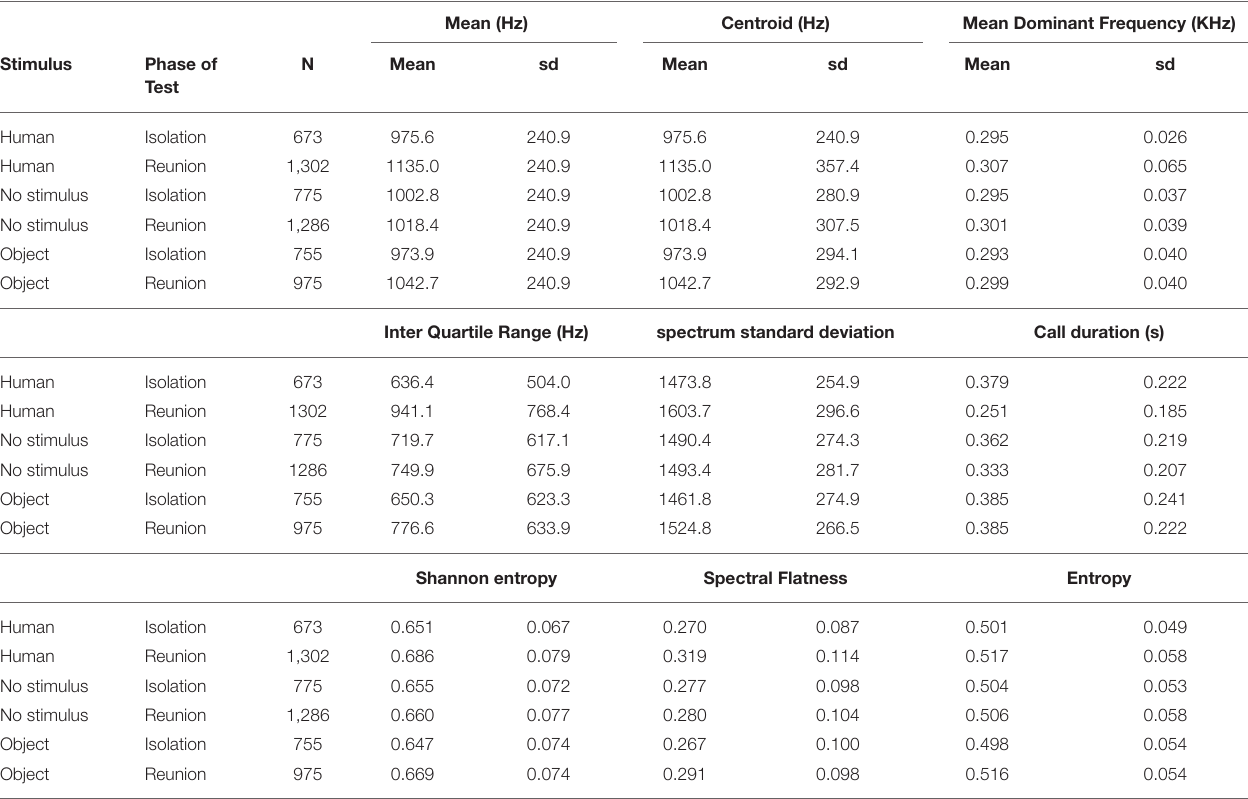
TABLE 5 | Raw values for acoustic parameters used in acoustic scores for significant interaction groups (stimulus and phase of test interaction). Mean (Hz) Centroid (Hz) Mean Dominant Frequency (KHz)